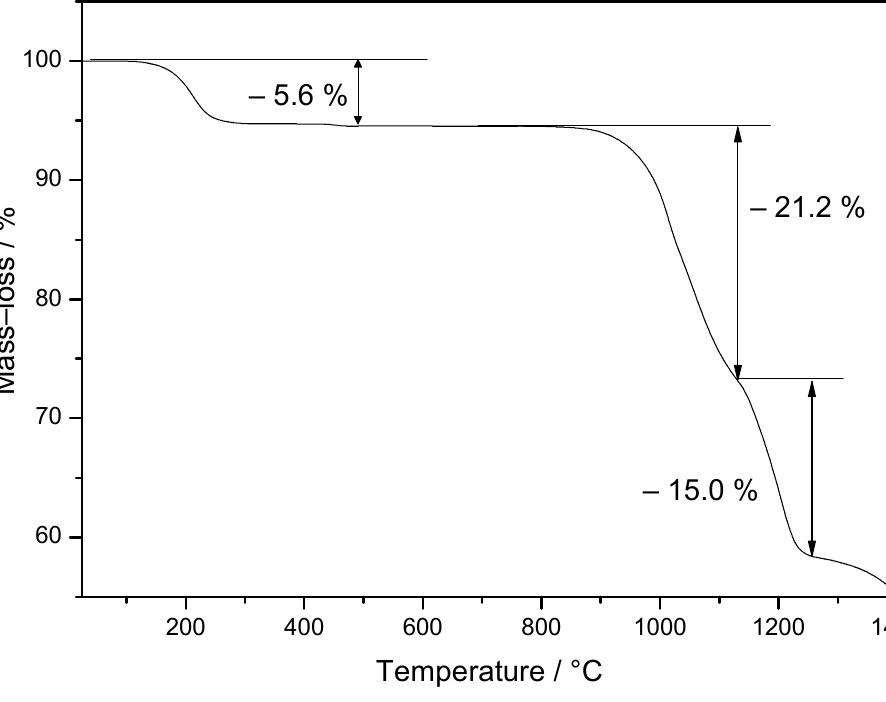
Figure 9. Thermogravimetrical curve of NaY[SO 4 ] 2 · H 2 O between 25 and 1400 ◦ C. The first mass-loss at about 180 ◦ C with 5.6% represents the release of water and the transformation from NaY[SO 4 ] 2 · H 2 O (100% mass; M = 322.036 g/mol) to NaY[SO 4 ] 2 (94.4% mass; M = 304.021 g/mol). The second decomposition leads to a mixture of Y 2 O 2 [SO 4 ] [55] with the crystal structure of monoclinic La 2 O 2 [SO 4 ] [56] and Eu 2 O 2 [SO 4 ] [57] or orthorhom- bic Nd 2 O 2 [SO 4 ] [58] together with Na 2 [SO 4 ] [51,59], confirmed by powder X-ray diffraction experiments (Figures S1 and S2 in the Supplementary Information). For Y 2 O 2 [SO 4 ], there are no known or other good crystal-structure data available, so there are differences in intensity and position, but the final decomposition step leads to a mixture of cubic Y 2 O 3 with a bixbyite-type structure [60] and orthorhombic Na 2 [SO 4 ] [51,59] (Figure S3). The TG curve (Figure 9) appears to be similar to that of Na RE [SO 4 ] 2 · H 2 O with RE = La, Ce, Nd, and Sm, which have been measured in 1994 by Kolcu and Zümreoˇglu-Karan [18]. The dehydration temperature of the lanthanum compound is 297 ◦ C and gets lower with de- creasing RE 3+ -cation radius along with the lanthanoid contraction [61]. With a dehydration temperature of 265 ◦ C for the samarium compound, this trend is further confirmed with our yttrium analog at 180 ◦ C. Additional to the thermogravimetry, temperature-dependent X-ray diffraction experi- ments were performed (Figure